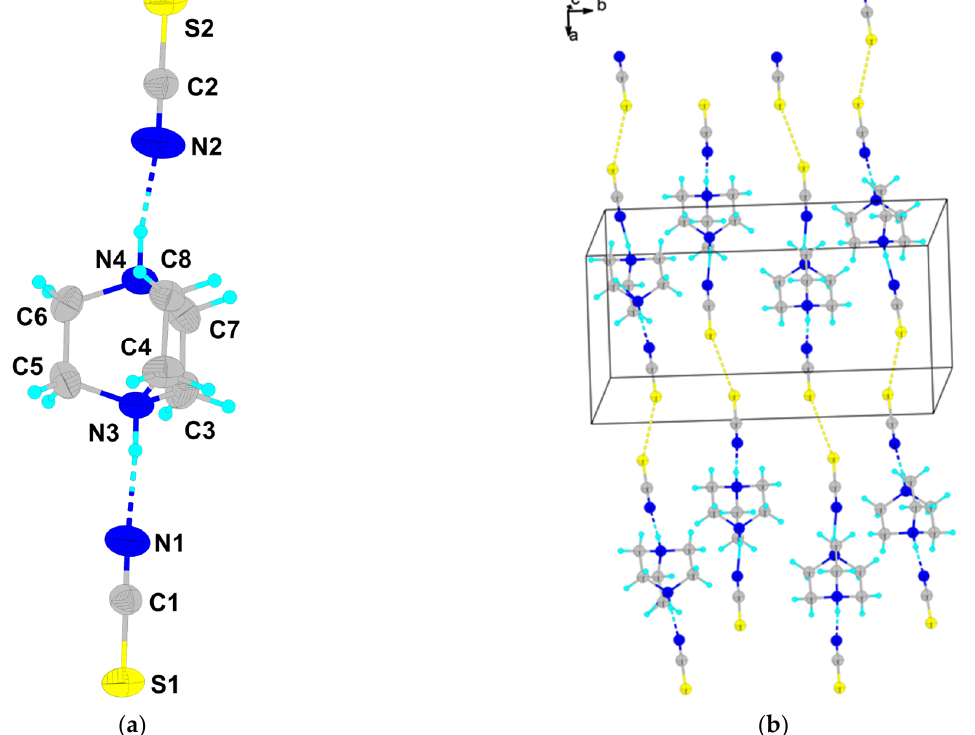
Figure 8. ( a ) (H 2 dabco)(SCN) 2 fragment in structure 6 . Thermal ellipsoids are drawn at the 50% probability level. ( b ) Formation of infinite chains via S...S interactions.